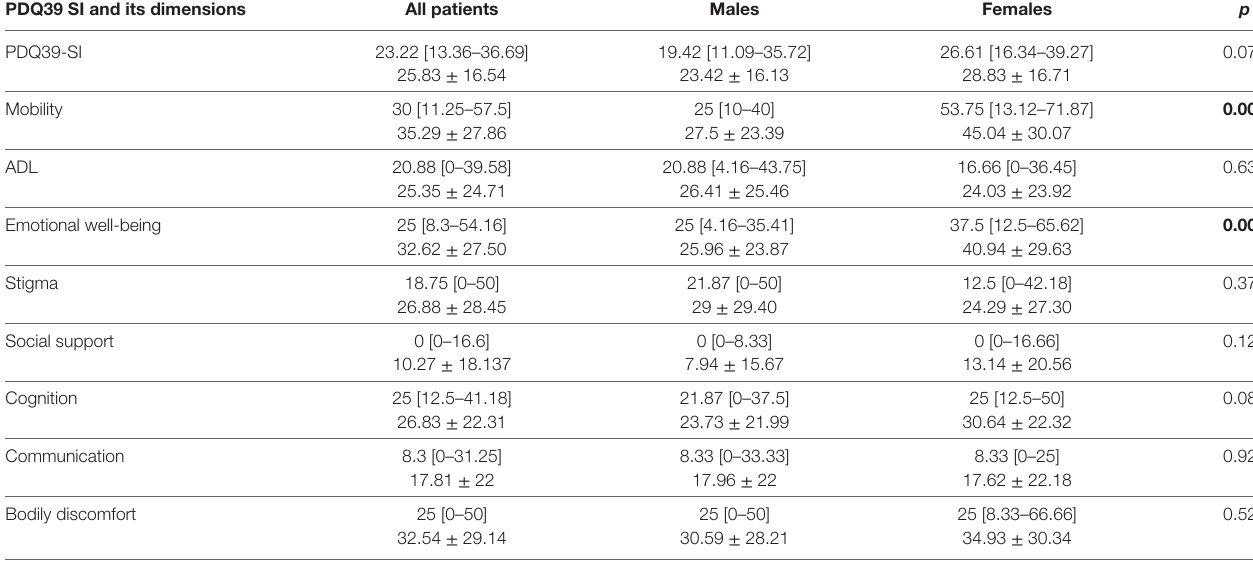
TaBle 4 | Dimensions of the PDQ39 in the study population.